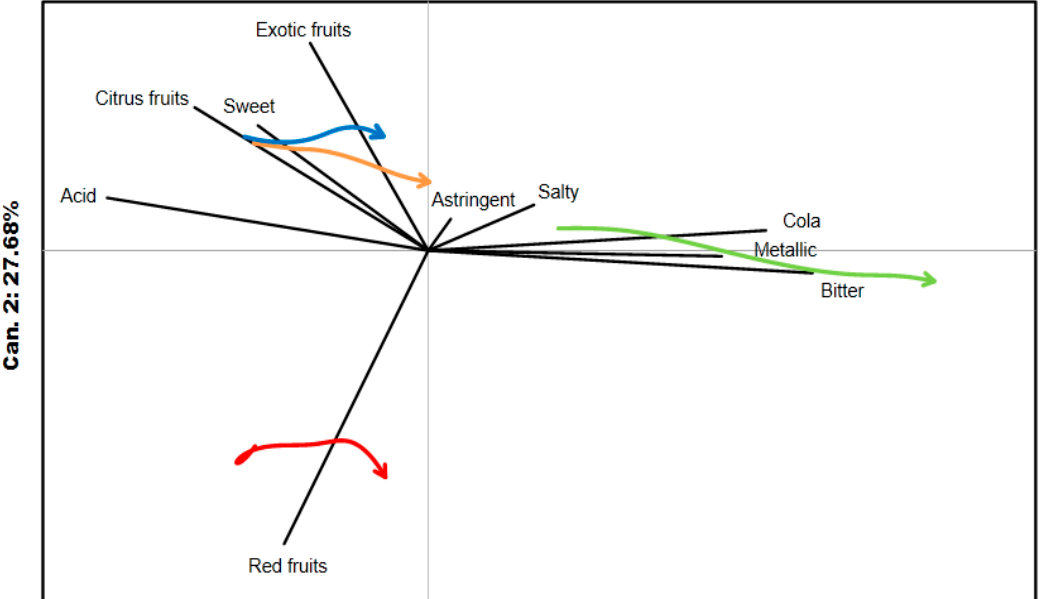
Figure 4. The sensory trajectories of the four products are represented on a PCA (Principal Component Analysis) biplot for TDS (Temporal Dominance of Sensations), at 10 equally spaced time points during oral processing. The sensory trajectories of the four products are each indicated by a different color: blue, ODT_exotic; green, ODT_cola; red, ODT_red; and orange, ODT_citrus.